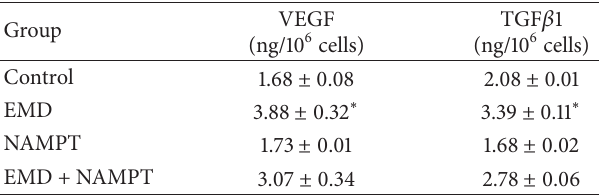
Table 1: Regulation of VEGF and TGF 𝛽 1 protein syntheses by EMD and/or NAMPT (100ng/mL) after 3 d, as analyzed by ELISA. Untreated cells served as control. Mean ± SEM ( n = 12); ∗ signifi- cantly ( 𝑃 < 0.05 ) different from all other